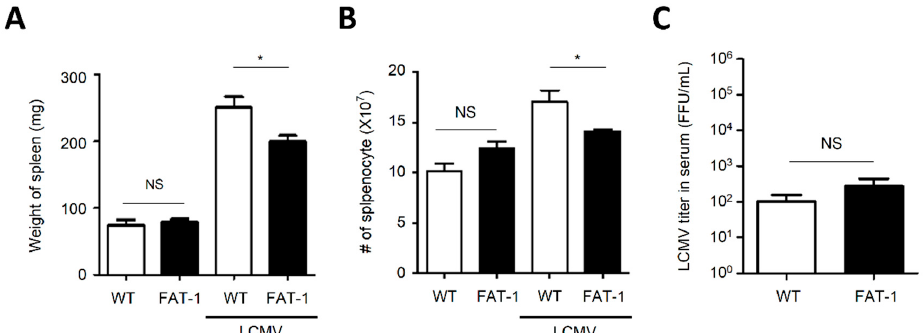
Figure 1. The expansion of splenocytes from FAT-1 mice was less than that of wild type (WT) mice upon infection with lymphocytic choriomeningitis virus (LCMV). WT and FAT-1 mice were infected with 2 × 10 5 focus-forming unit (FFU) of LCMV (Armstrong) for 7 days. ( A ) The weight of spleens from WT and FAT-1 mice were measured. ( B ) The total number (#) of splenocytes from WT and FAT-1 mice were counted. ( C ) Viral titers in the serum of WT and FAT-1 mice were determined by focus-forming assays. The data represent the mean ± SEM. * p ≤ 0.05; NS, not significant. The data represent the results of at least three independent experiments.